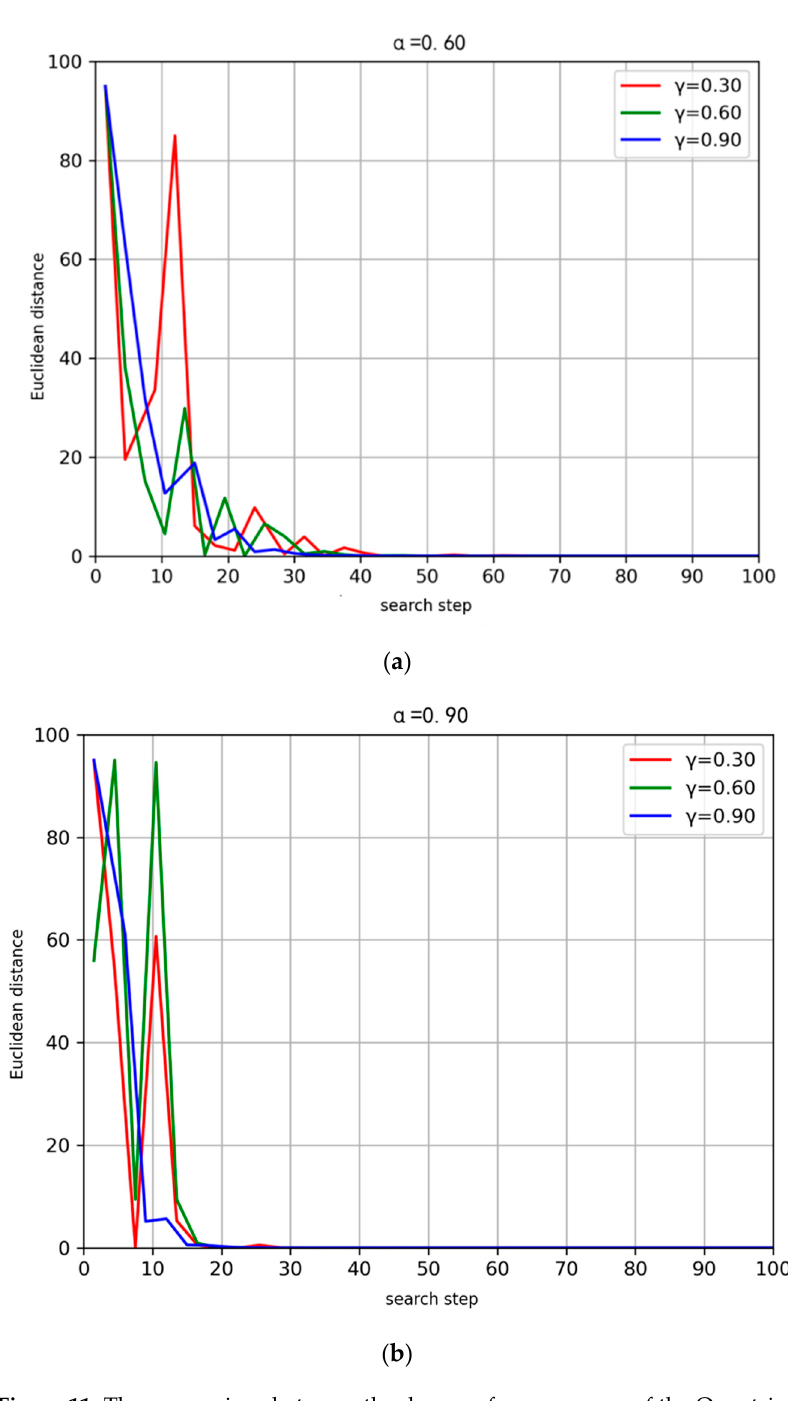
Figure 11. The comparison between the degree of convergence of the Q matrix and the number of search steps under different values of α and γ . ( a ) α = 0.6, under different γ , the comparison chart of the convergence degree of Q matrix. ( b ) α = 0.9, under different γ , the comparison chart of the convergence degree of Q matrix.